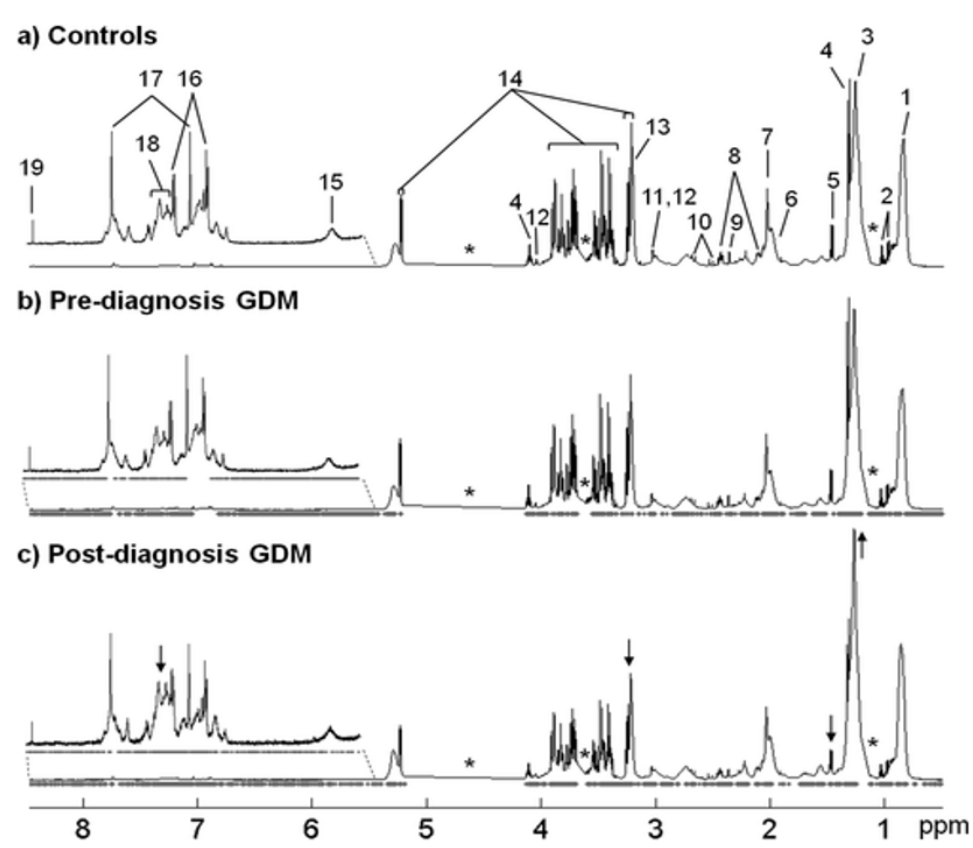
Figure 4. The HNMR spectra of plasma of ( a ) controls, ( b ) pre-diagnosis GDM, and ( c ) post-diagnosis GDM. Arrows specify the visible alterations; * = excluded spectral regions. (1) CH 3 lipids, (2) Val, (3) (CH 2 )n lipids, (4) lactate, (5) Ala, (6) CH 2 C=C lipids, (7) N-acetyl glycoproteins, (8) Gln, (9) pyruvate, (10) citrate, (11) creatinine, (12) creatinine, (13) N(CH 3 ) 3 choline of PL, (14) glucose, (15) urea, (16) Tyr, (17) His, (18) unknown ( δ 7.15 − 7.35), and (19) formate [39].